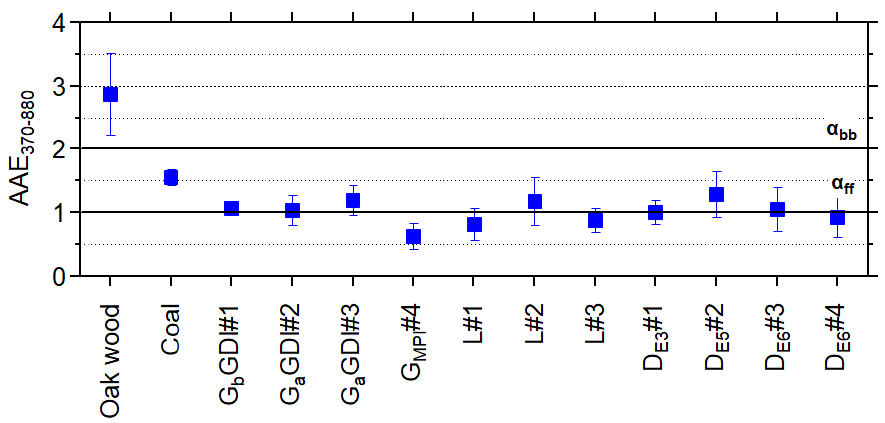
Figure 10. Calculated AAE values in this study. α bb : AAE of biomass burning, α ff : AAE of fossil fuel burning for the average results of the NIER modes [33–35].